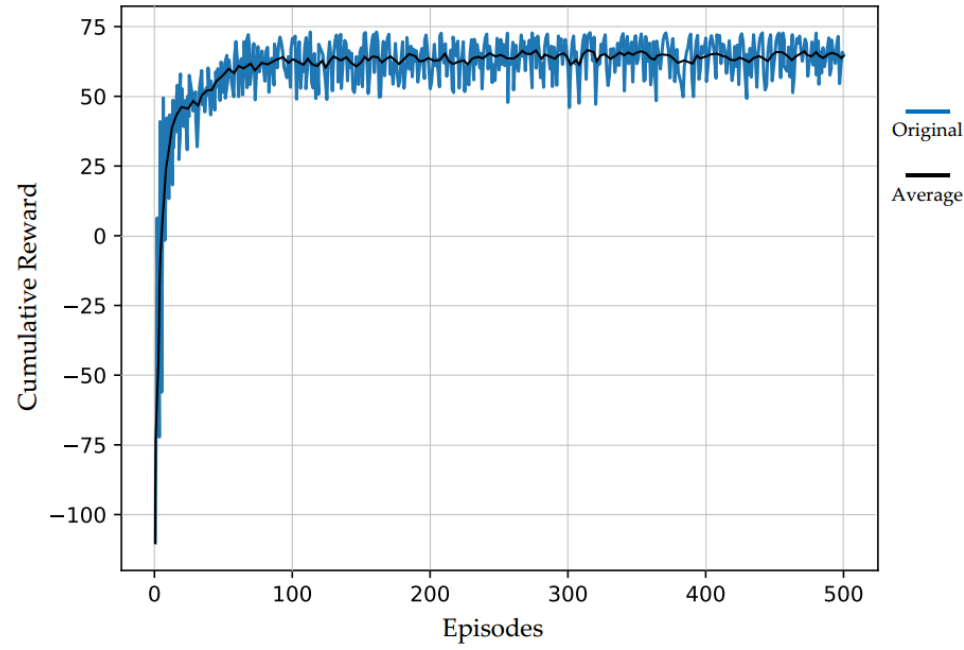
Figure 5. Cumulative Reward vs. Episodes.